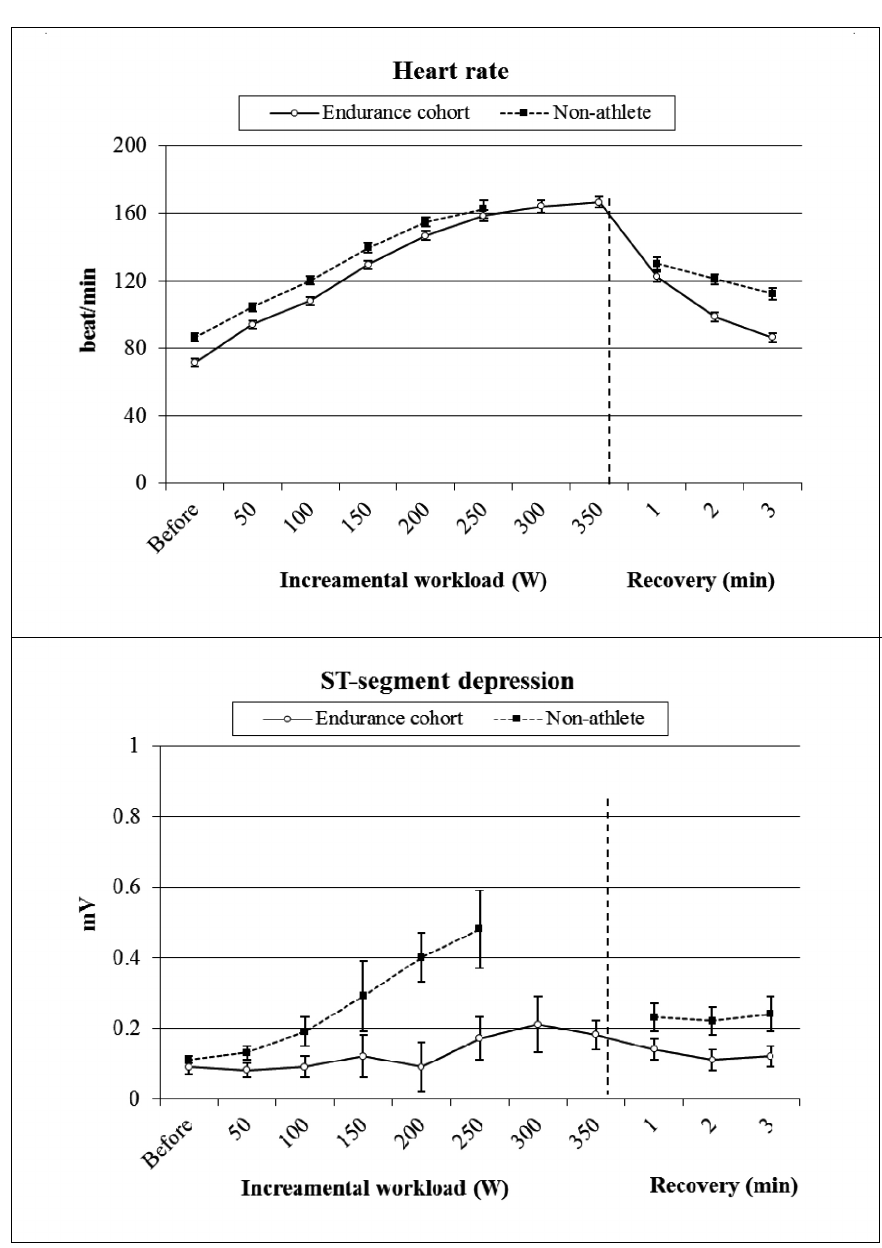
Figure 1. Dynamics of HR